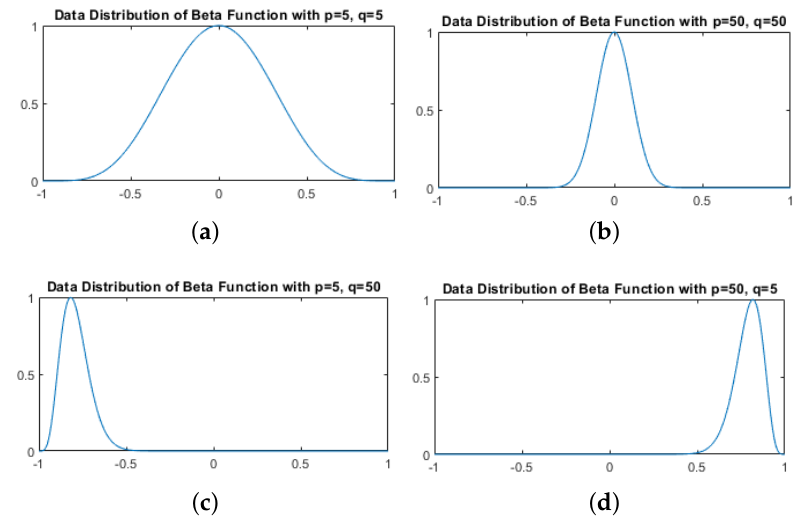
Figure 4. Different Data Distributions of Beta Function with Different Configurations of p and q : (a) large Gaussian data distribution, (b) narrow Gaussian data distribution, (c) exponential decrease data distribution, (d) exponential increase data distribution. Table 6. Taguchi Array Design L 8 ( 2 6 ) of DB − CSA − II for DMOPs and of DB − CSA for